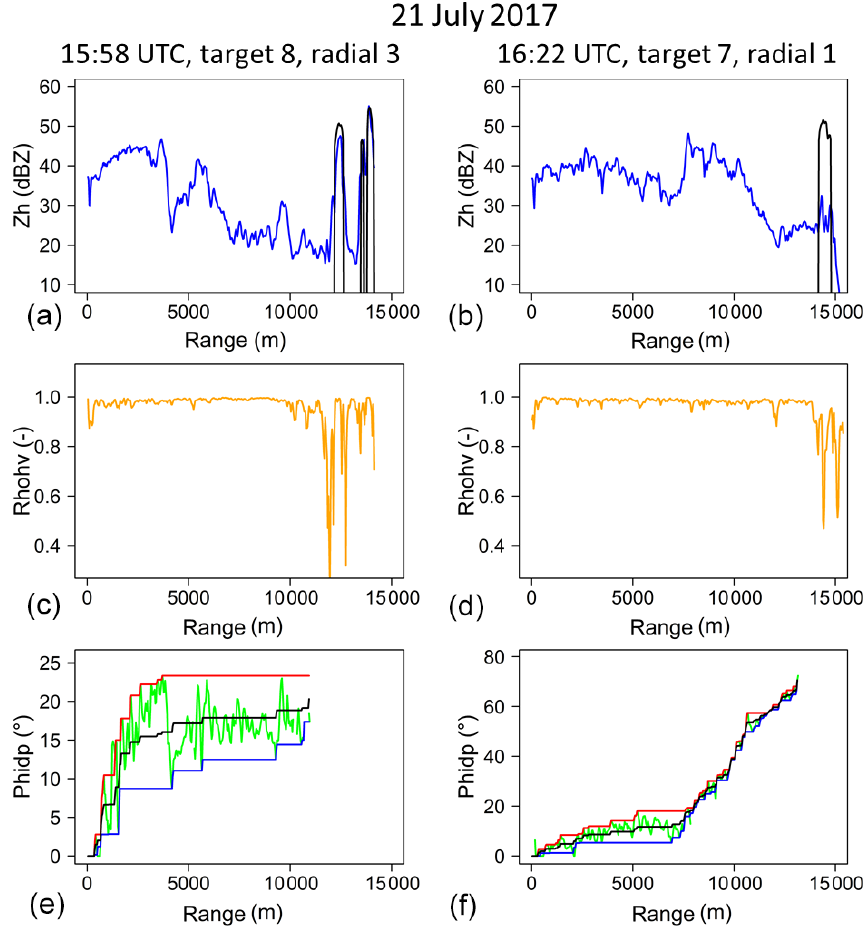
Figure 4. Two examples (right and left columns) of Z h , ρ hv , and φ dp range profiles of the XPORT radar (7.5 ◦ PPI) during the 21 July 2017 convective event for one radial of a given mountain target. The raw horizontal reflectivity profiles (a, b) at the considered time steps (blue) are displayed together with the dry weather reference target value (black). The ρ hv profiles (c, d) are used to detect the rainy gates not affected by clutter at close range and in the region of the mountain target. Panels (e) and (f) display the raw ψ dp profiles (green), the upper (red) and lower (blue) envelope curves, and the regularized φ dp profiles